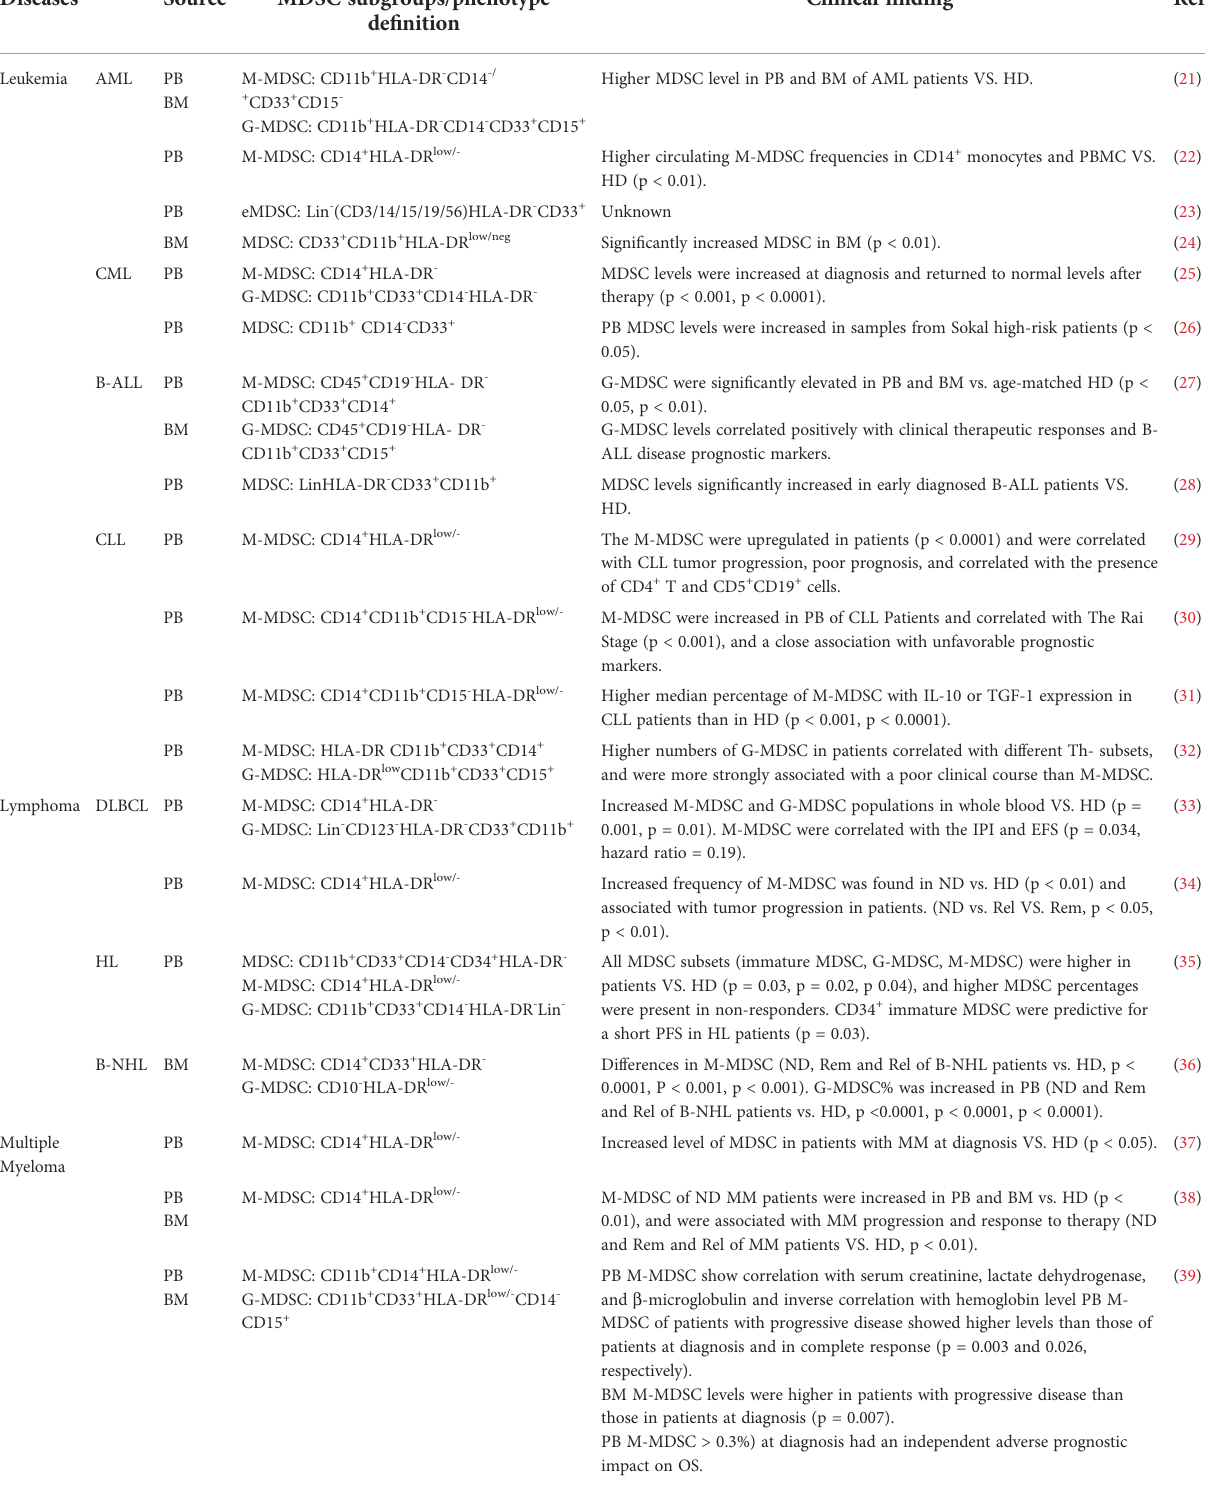
TABLE 1 Summary of MDSC representative phenotype and their prognostic role in different hematological cancers.